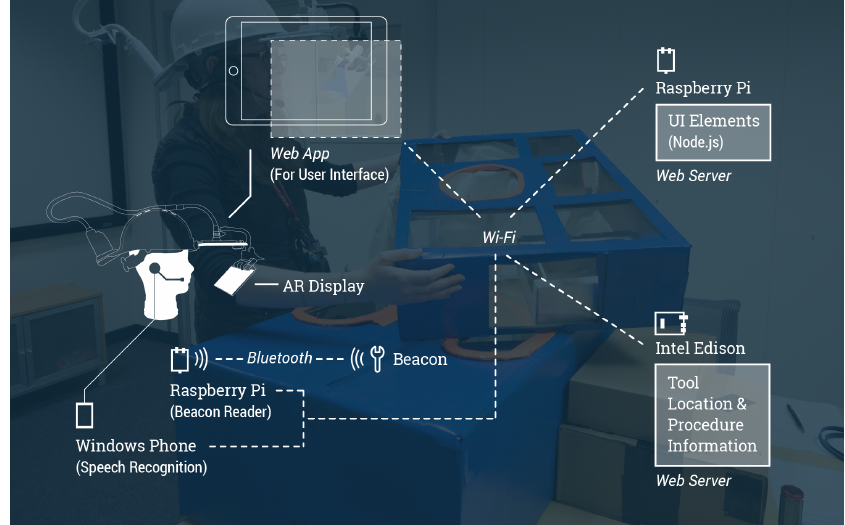
Figure 6. Networking diagram showing the connections over Wi-Fi of the two Raspberry Pis, Intel Edison, Windows Phone, and Web